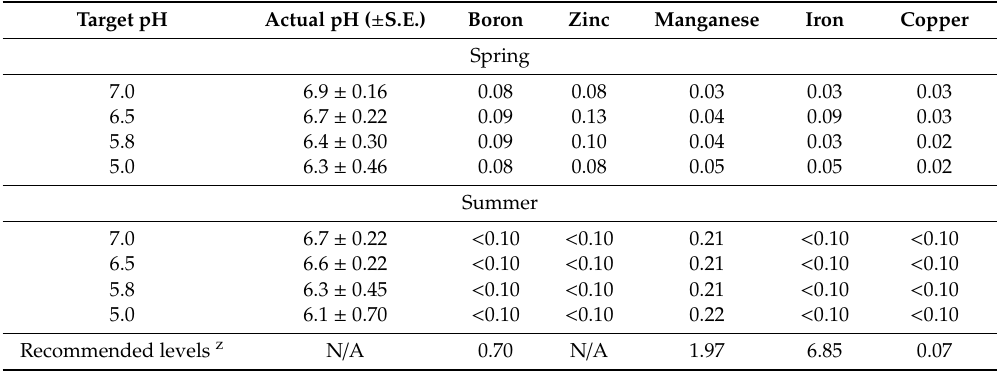
Table 6. Midseason micronutrient analysis (mg · L –1 ) of aquaponic irrigation water at four target pH treatments.